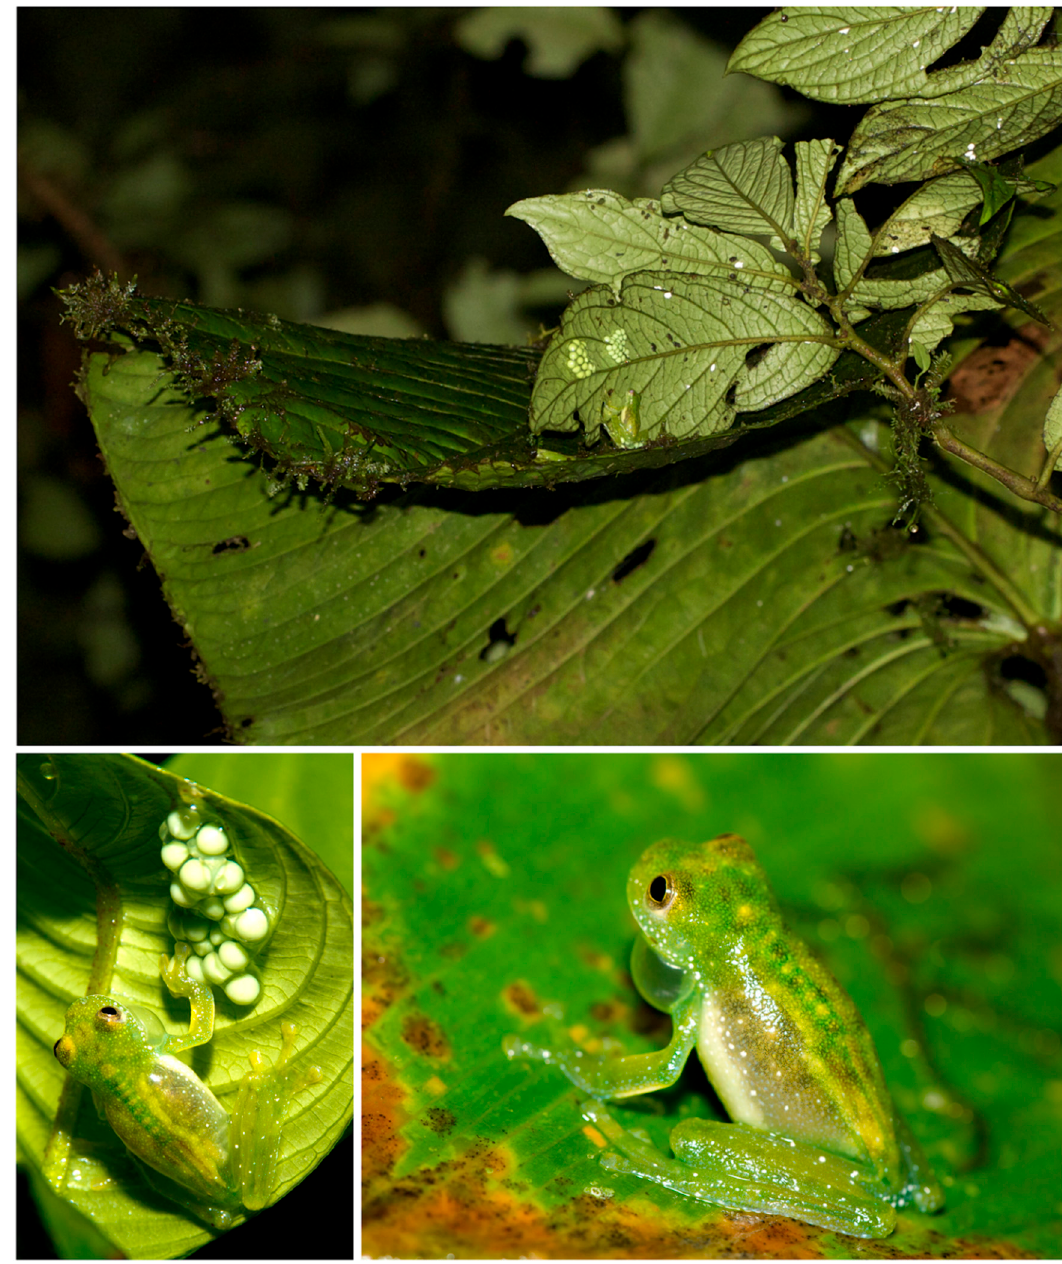
Figure 50. Centrolene peristicta in life. Top row: Male guarding two egg clutches; Reserva Las Gralarias. Bottom left: Adult male guarding eggs, from Mindo Biological Reserve, QCAZ 22313; photo by Martín Bustamante. Bottom right: Individual from Reserva Las Gralarias; photo by Marco Rada. Diagnosis: (1) Vomers lacking teeth; (2) snout round in dorsal aspect, round or truncated in lateral profile (Figure 51); (3) tympanum large, oriented almost vertically, with slight lateral and posterior inclinations, its diameter 44.0%–51.9% of eye diameter; tympanic annulus visible, supratympanic fold evident; tympanic membrane translucent, partially pigmented, differentiated from surrounding skin; (4) dorsal skin shagreen with small warts corresponding to yellowish–white spots, males and females lack spicules; (5) pair of enlarged subcloacal warts (Figure 15); (6) anterior half of the ventral parietal peritoneum white, posterior half transparent (condition P2); white pericardium; iridophores partially or completely covering stomach and colon; no iridophores in peritonea covering kidneys, gall bladder, and urinary bladder (condition V2); (7) liver with four clearly defined lobes, lacking iridophores (condition H0); (8) males with conspicuous humeral spines; (9) webbing absent between Fingers I and II, reduced between Fingers II and III, and moderate to